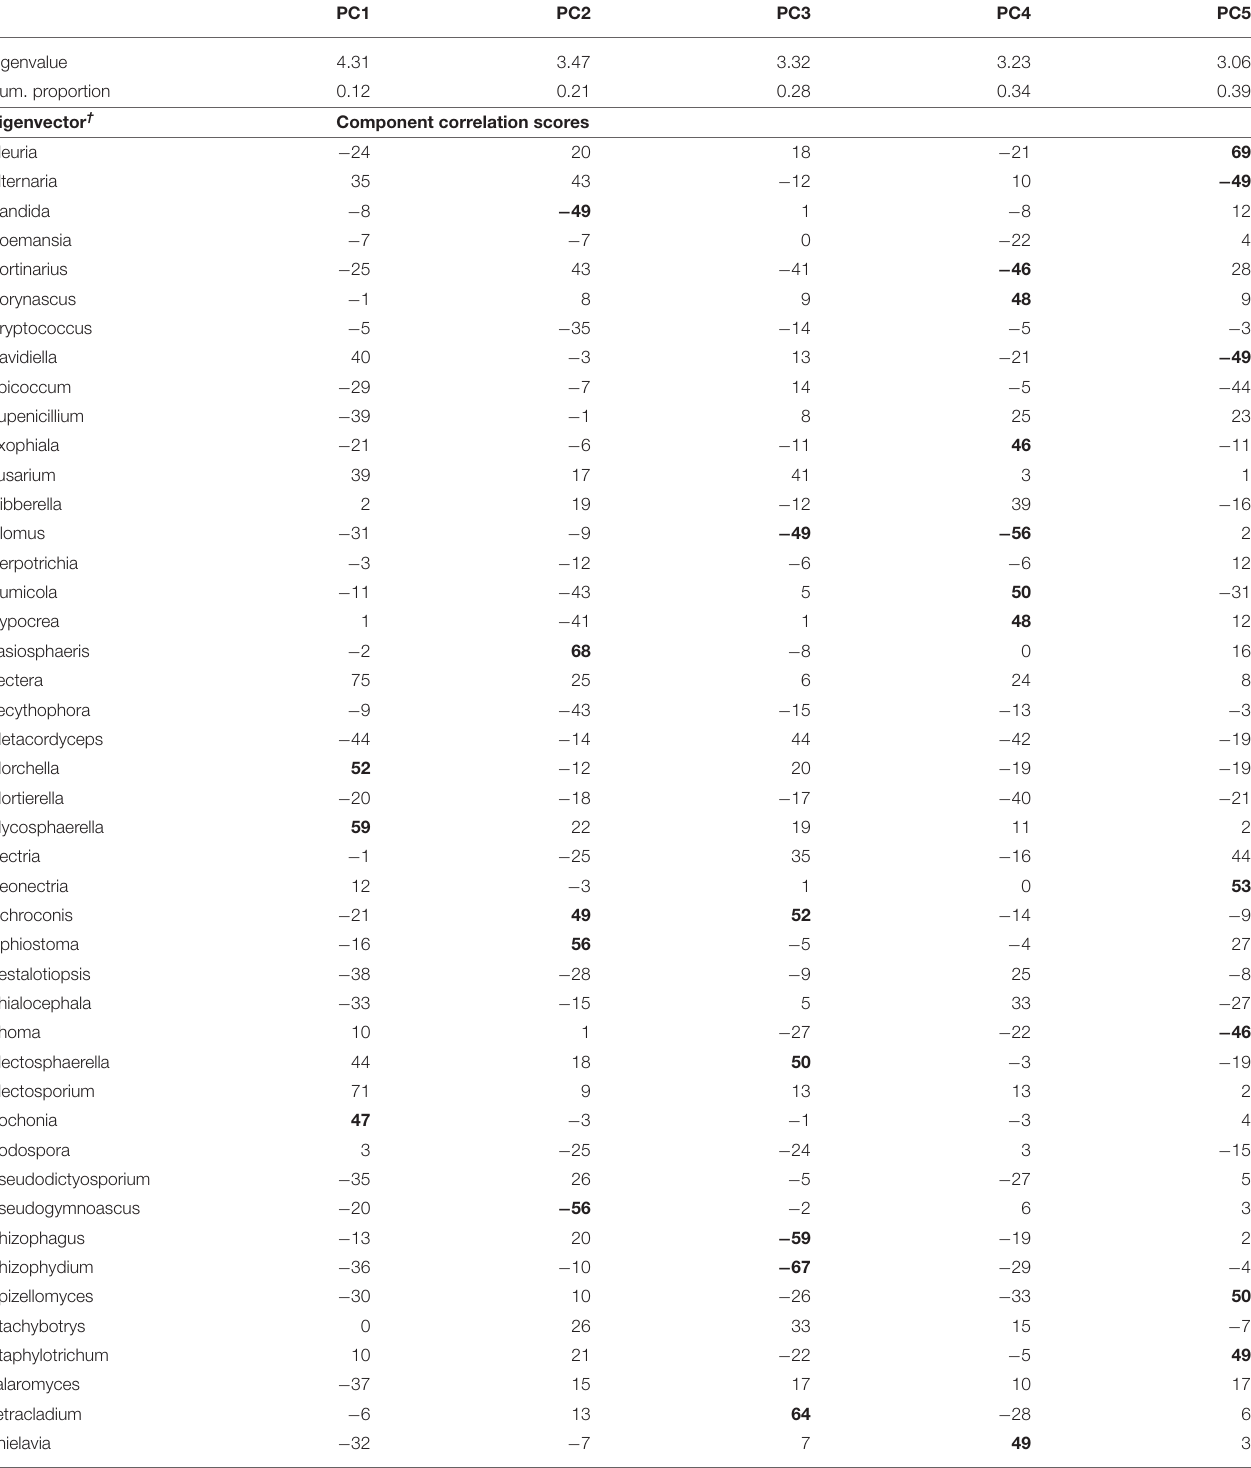
TABLE 4 | Results of the principal component analysis of fungal genera showing the eigenvalues, the cumulative proportion of variability explained, and the eigenvectors for each of the five principal components (PC) extracted. PC1 PC2 Eigenvalue Cum. proportion